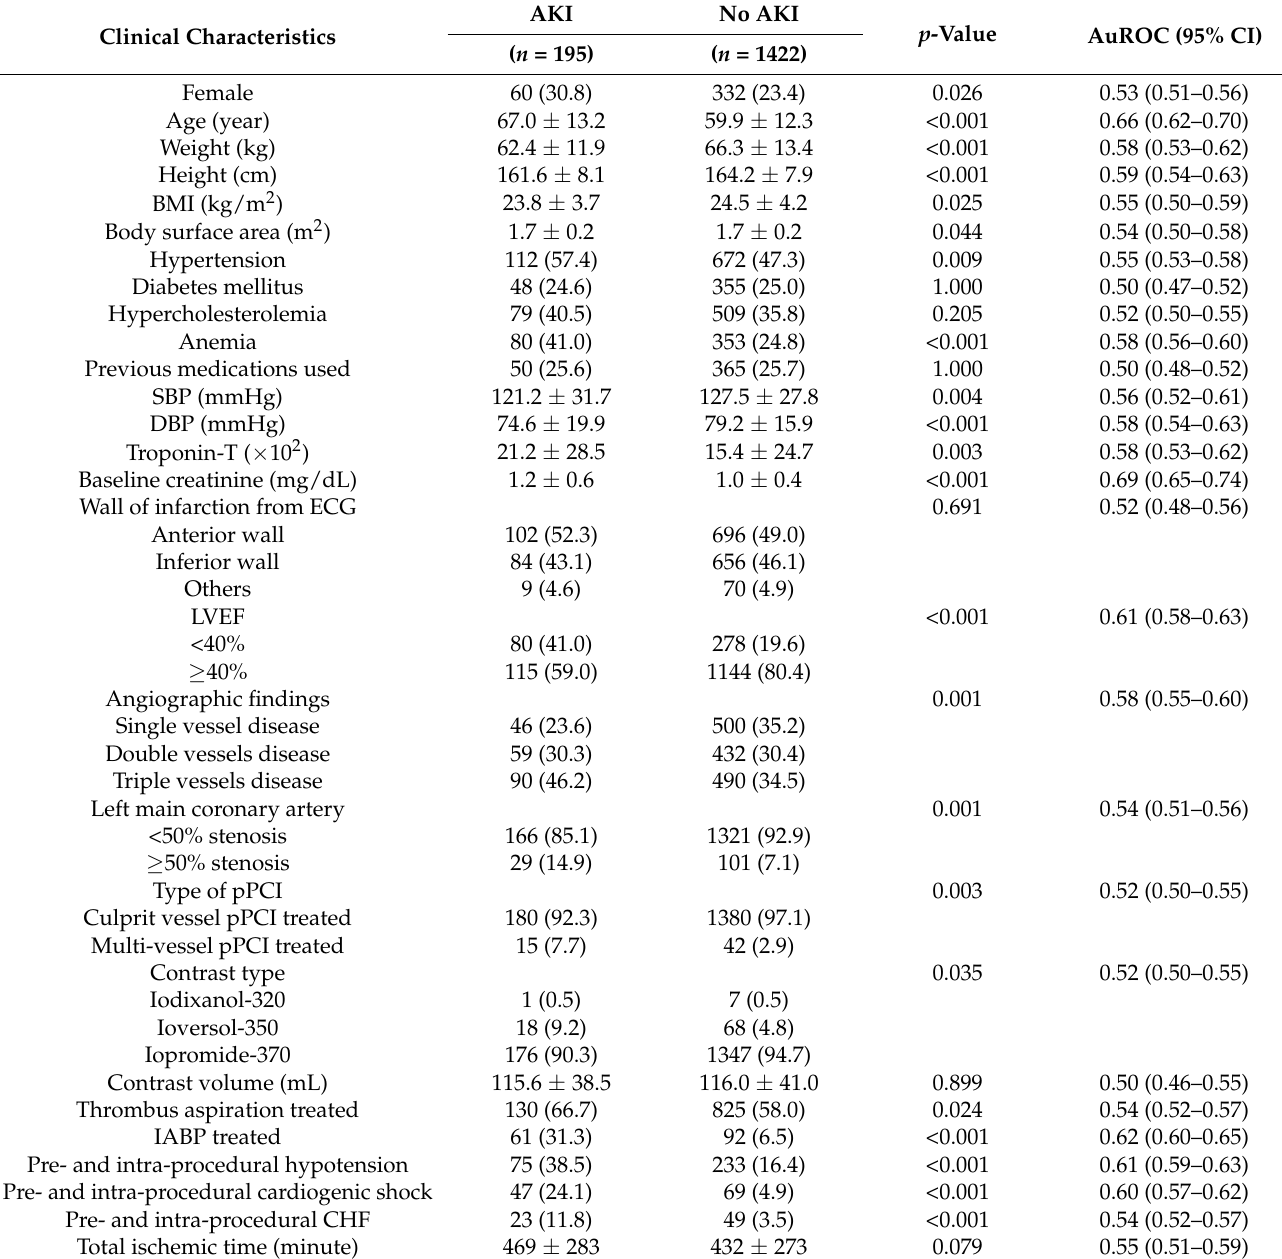
Table 1. Baseline characteristics, pathology, pathophysiology, procedure, findings, and complication in patients with or without